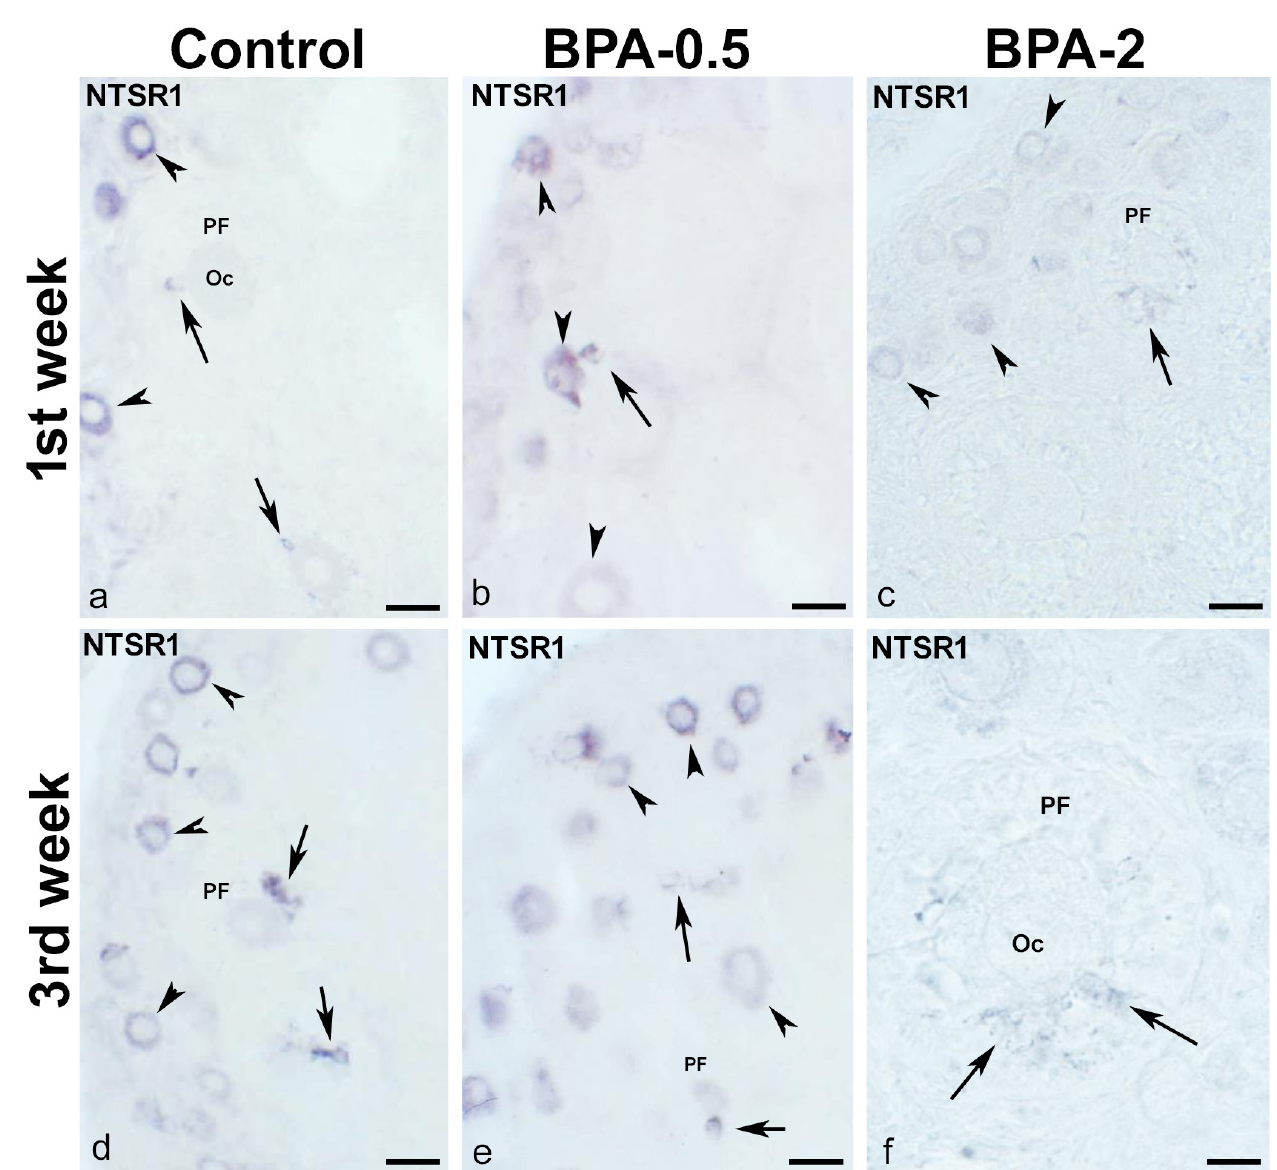
Figure 9. NTSR1 immunoreactivity in offspring ovaries . Representative images of the ovary in the three experimental groups in the first ( a – c ) and third ( d – f ) weeks of postnatal life show the presence of NTS-ir in oocytes from primordial follicles (arrowheads) as well as in granulosa cells from different primary follicles (arrows). Oc: oocyte; PF: primary follicle. Scale bars: ( a – e ): 40 µm; ( f ): 15 µm. In dams after weaning, NTS-ir and NTSR1-ir cells were observed in oocytes and granulosa cells in all groups (Figure 10a–f), with the only difference between the control and BPA-treated groups being the higher proportion of NTS and NTSR1-ir oocytes in BPA-treated